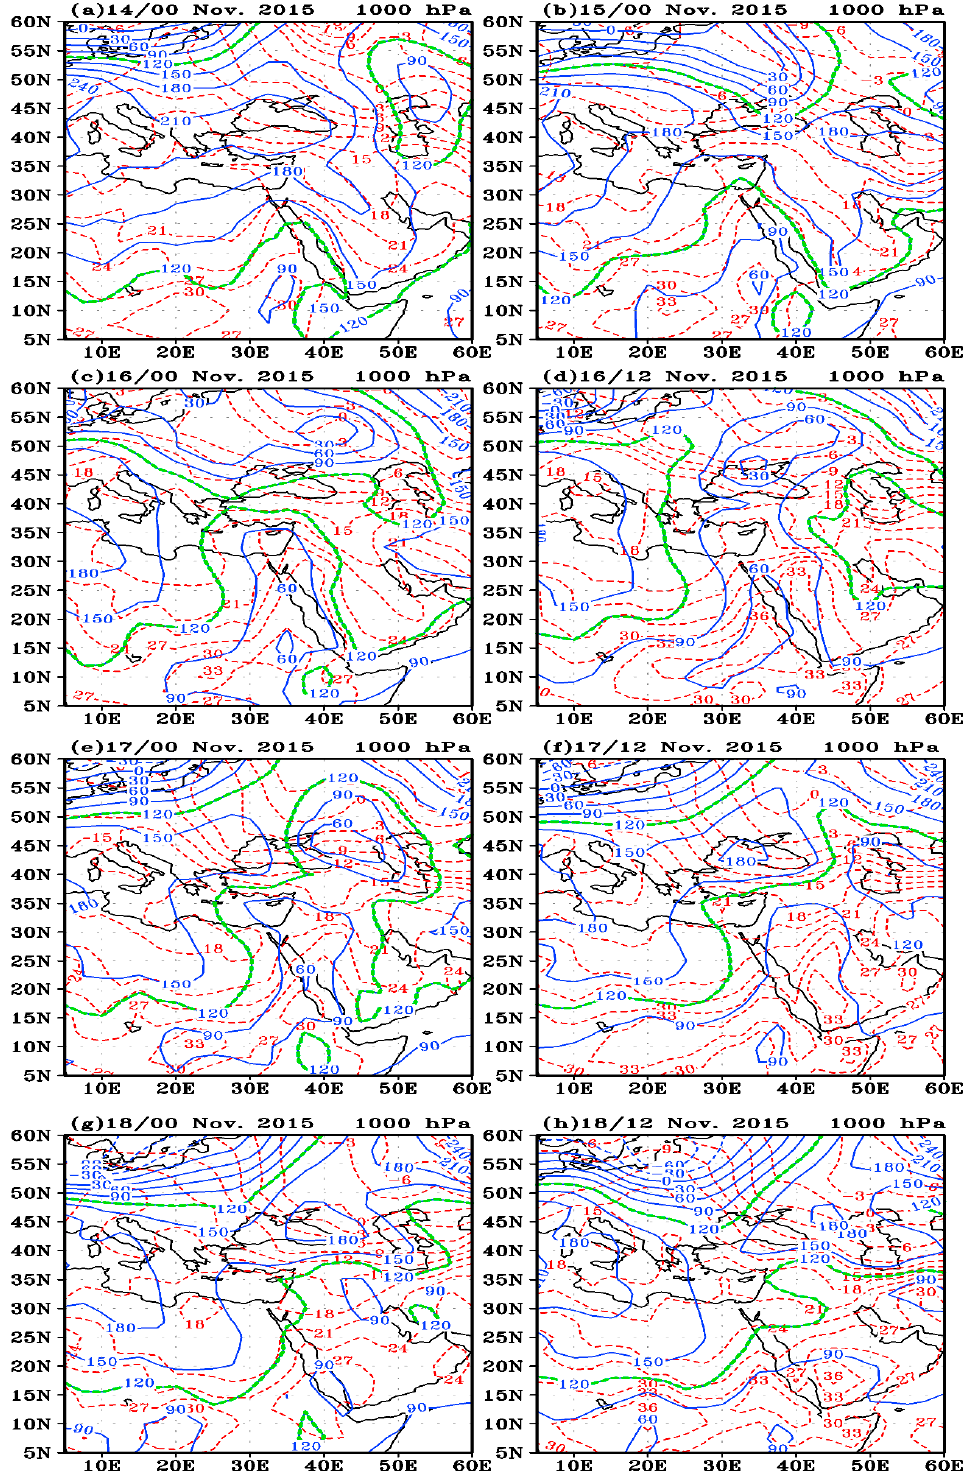
Figure 2. 1000 hPa geopotential height with 20 m contour intervals (blue and green solid lines) and temperature (red dashed lines) every 3 °C ( a – h ) for the period 14–18 November 2015.